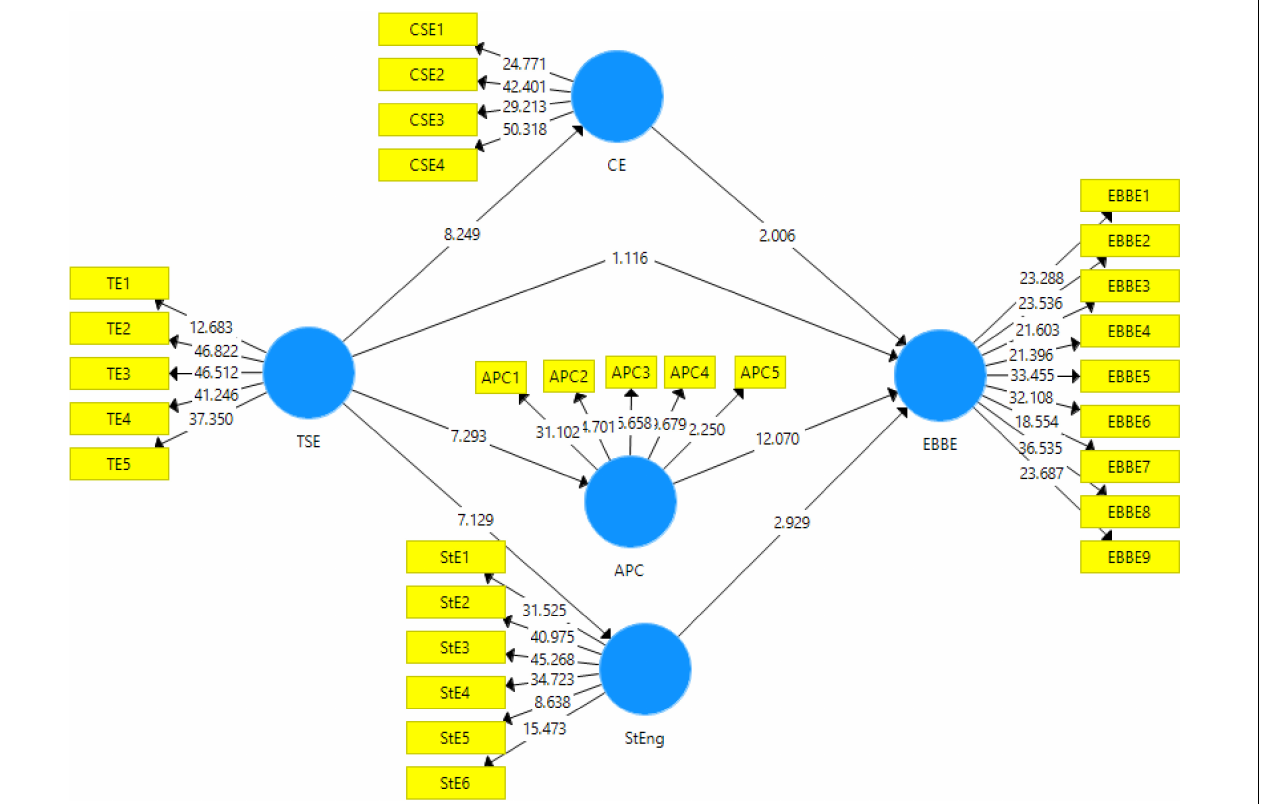
FIGURE 3 | Output of structural model